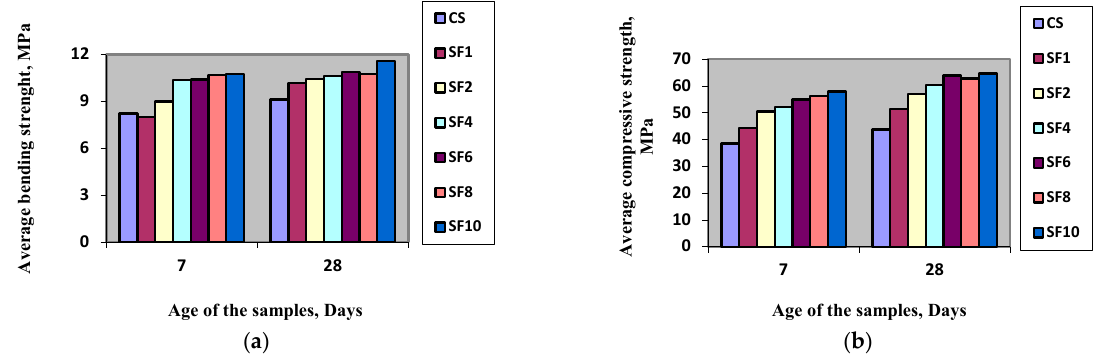
Figure 3. Compressive and bending strength of mortar containing micro-silica.